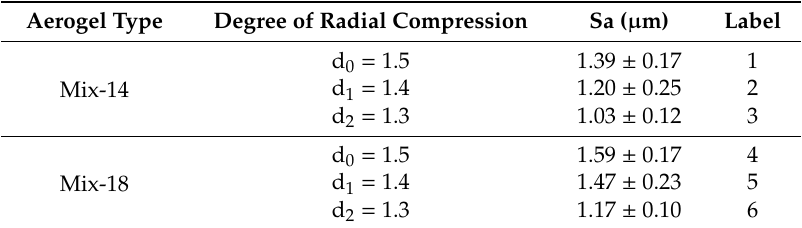
Table 2. Surface roughness (Sa) of each SSMPA used in this study.